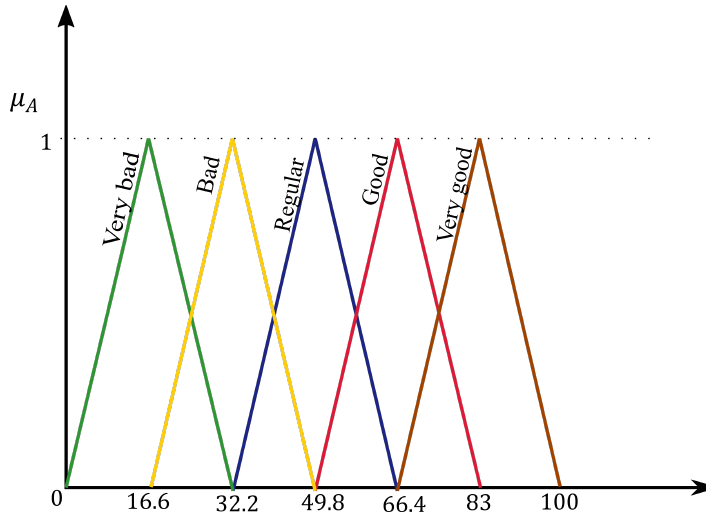
Figure 4. Graph of fuzzy triangular